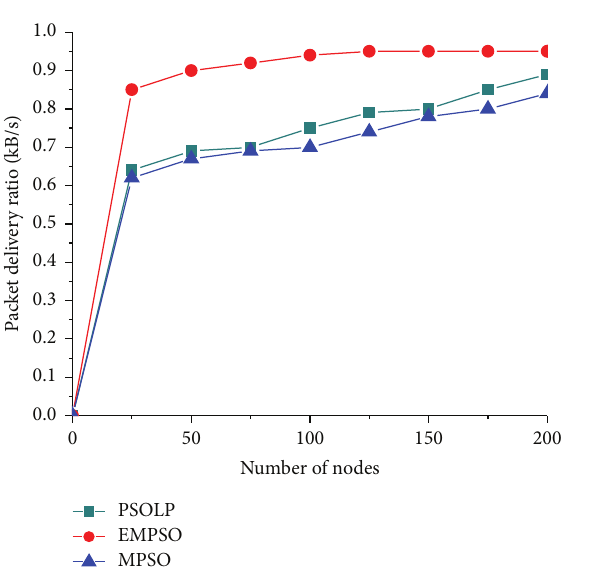
Figure 3: Packet delivery ratio versus number of nodes.